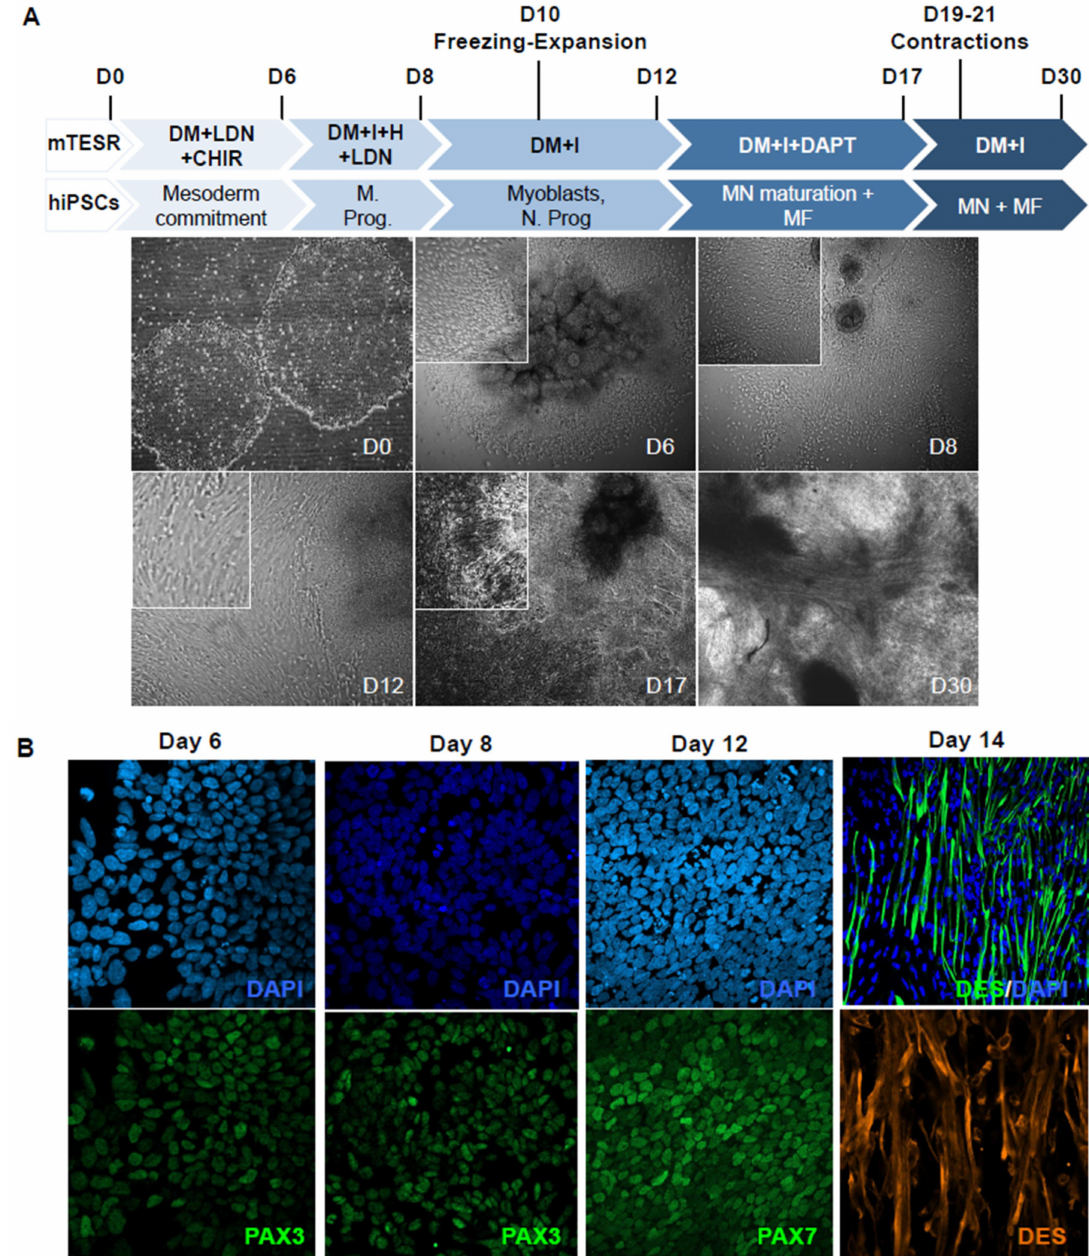
Figure 1. Protocol for myogenic di ff erentiation. ( A ) Time line and phase contrast images of cells di ff erentiated from human induced pluripotent stem cells (hiPSCs) at Day 0 (D0), D6, D8, D12, D17 and D30, corresponding to changes in the composition of the medium. Thiazovivin, an inhibitor of the ROCK pathway, was added at the time of plating and two days after. The composition of the medium is indicated for the di ff erent culture steps. CHIR: CHIR99021; LDN: LDN193189; F: FGF2; I: IGF1; H: HGF; DAPT: N-[N-(3,5-Difluorophenacetyl)-L-alanyl]-S-phenylglycine t-butyl ester. Cells could be frozen between Days 10 and 12 for storage, expansion and further di ff erentiation. First contractions were visible between day 19 and 21 postdi ff erentiation. ( B ) Representative Z stack after confocal microscopy of cultures stained with anti-PAX3 antibody at Day 6 and Day 8 postdi ff erentiation, and Day 12 with anti-PAX7. Representative immunostaining of early myofibers at Day 14 stained for the sarcomeric Desmin (green). Cells were counterstained with